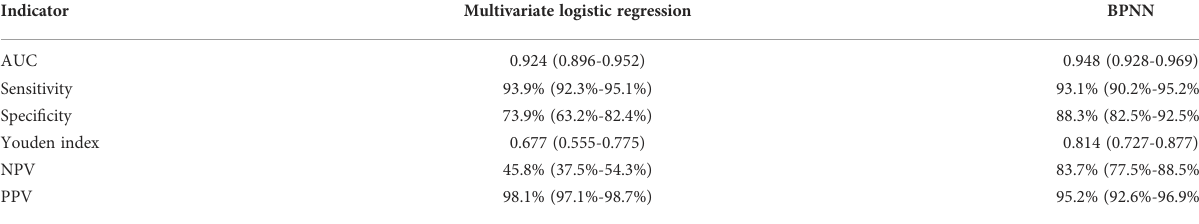
AUC, area under receiver operating characteristic curve (95% CI is shown in parentheses); BPNN, back propagation neural network; NPV, negative predictive value; PPV, positive predictive value. Youden index=sensitivity+speci fi city-1.